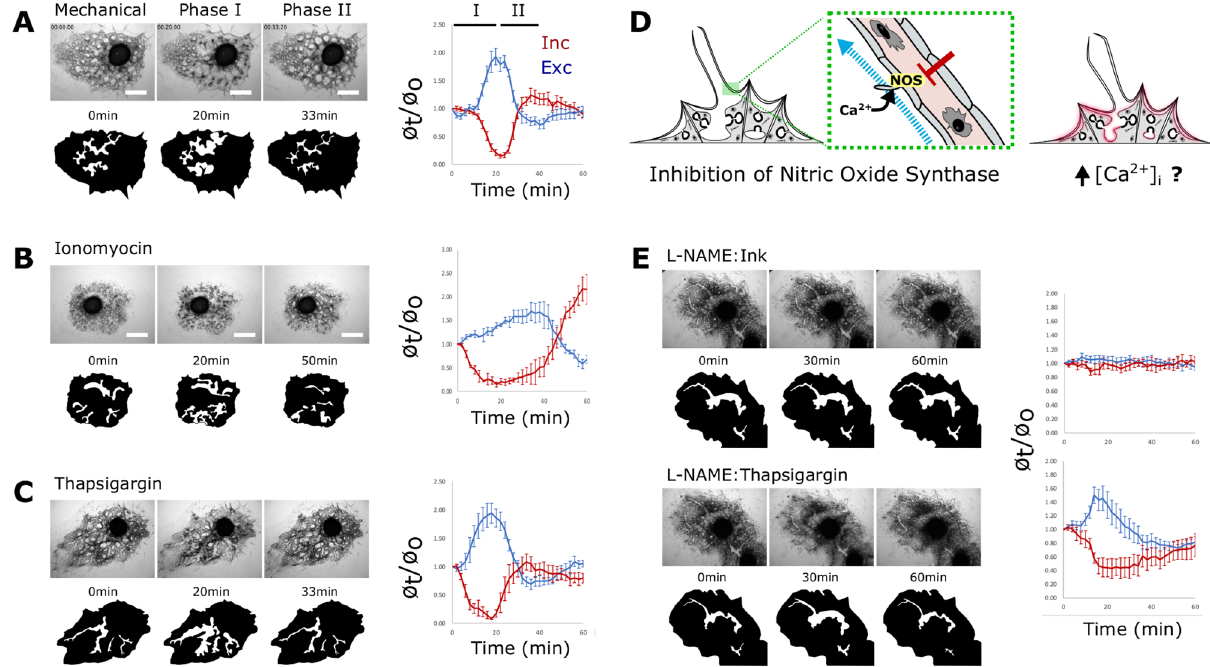
Fig. 3 Contractions are regulated by calcium. A – C Time-lapse images depicting sponge contractions A stimulated mechanically, B by 300 nM Ionomycin, or C by treatment with 1 nM thapsigargin. Below each image, an excurrent canal is highlighted in white to show how its diameter changed over the treatment time-course. Graphs (right) plot phase I and II contraction dynamics ( n = 5 or 6 individual measurements for incurrent and excurrent canals per sample). D Simpli fi ed work fl ow, as sensory cells are known to require external calcium2 does raising intracellular calcium concentration downstream of them still elicit a contraction? E Top: time points of a sponge treated with 20 µ M L-NAME and challenged to contract with 1:1000 Sumi Ink. Bottom: the same sponge treated with 1 nM thapsigargin. Graphs show the average canal diameter relative to the fi rst frame for both incurrent (red) and excurrent (blue) canals ( n = 6 individual measurements for incurrent and excurrent canals per sample). Analysis was also performed on sponges from